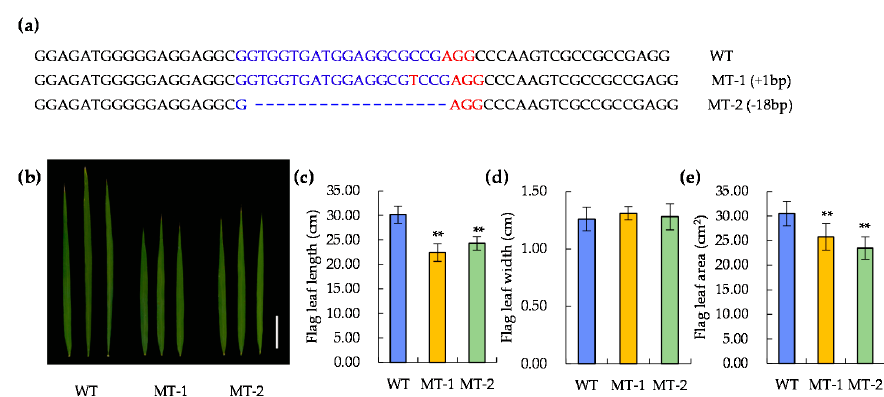
Figure 7. CRISPR/Cas9 vector construction. ( a ) Primer sequence on LOC_Os09g26999 . ( b ) The intermediate vector SK-gRNA contains the U3 promotor and sgRNA scaffold. ( c ) Binary vector pC1300-Cas9 contains the 2 × 35S promotor and a Cas9 protein. SK-gRNA- Os09g26999 are digested with Kpn I and Bgl II, respectively, and cloned into pC1300-Cas9 (digested with Kpn I and BamH I) by a one-step ligation.